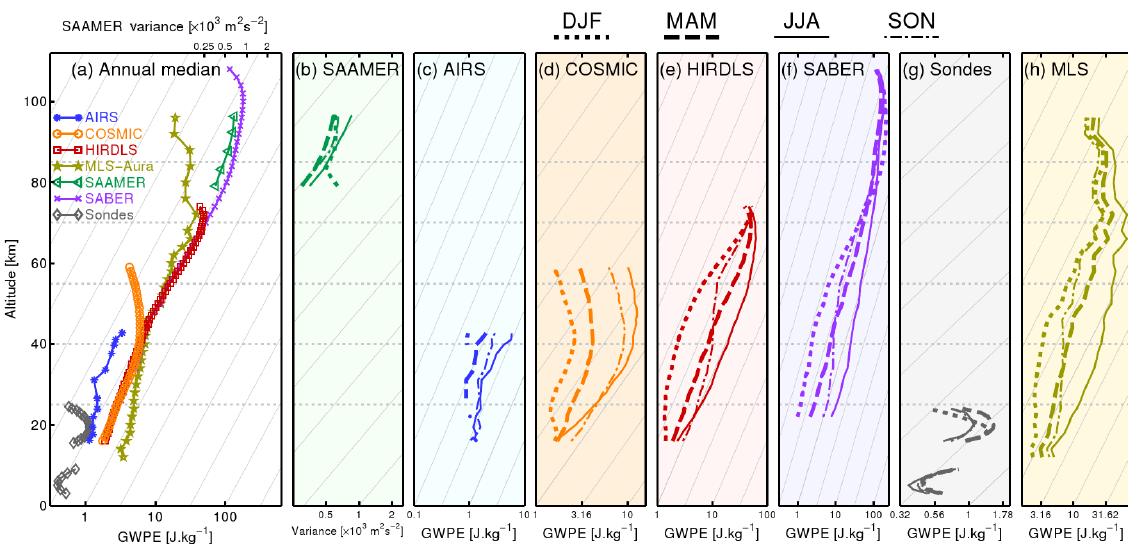
Figure 10. (a) Annual median GWPE (except SAAMER, variances, shown on top axis) observed by each instrument at each analysed height level. Grey horizontal lines indicate height levels studied in more detail later in this study. (b–h) Seasonal variability for each instrument. Table 1. Sample literature values for GWPE in the region of interest, selected as the set of articles otherwise referenced in this study with values either provided in units of GWPE or equivalent convertable units (e.g. T (cid:48) ). All values are highly approximate. Values originally published in terms of other quantities have been converted to GWPE by assuming N = 0 . 02 and g = 9 . 81, and deriving a mean background temperature ¯ T for the season of interest from ECMWF operational